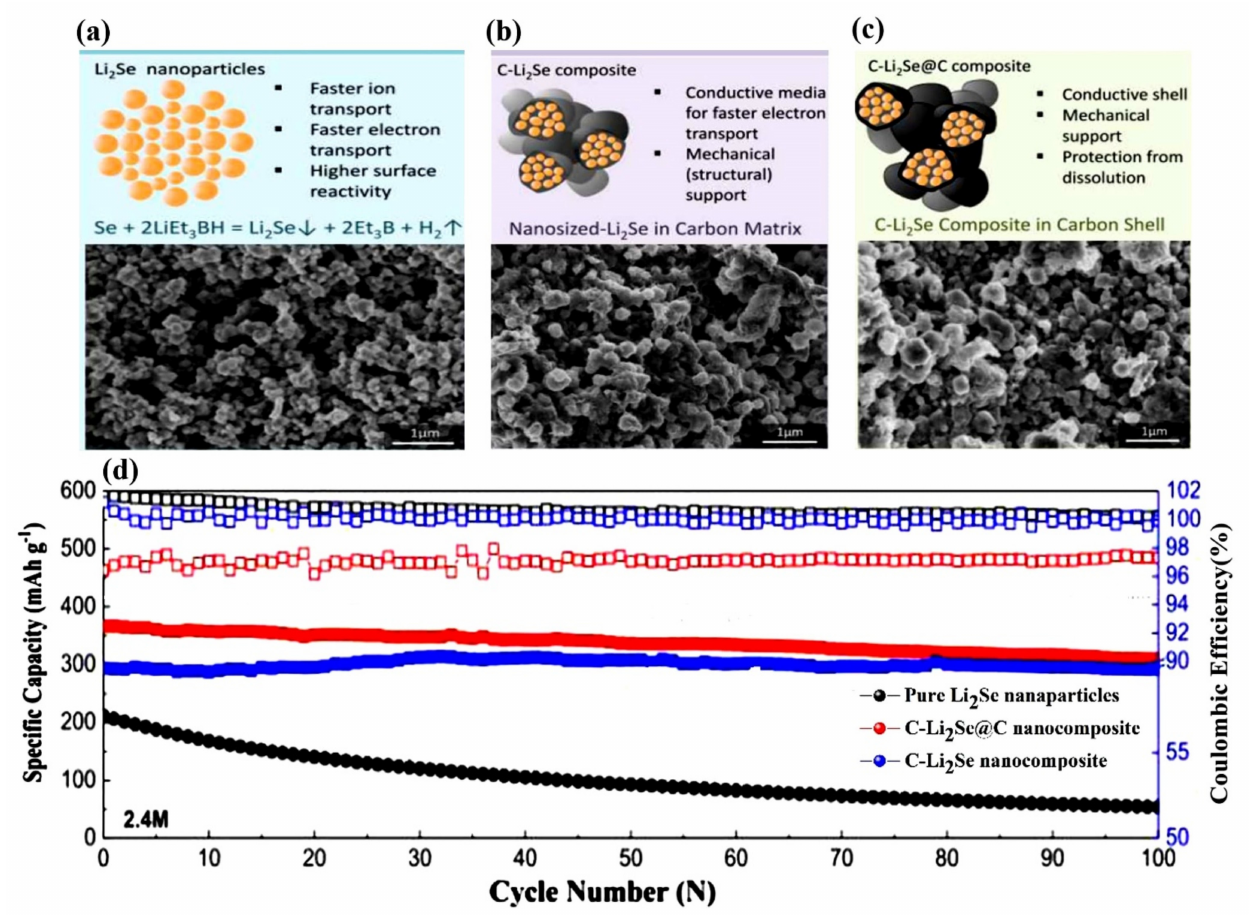
Figure 10. ( a ) Li 2 Se nanoparticles synthesized by a chemical reaction between Se powder and Li reducing agent (such as a lithium hydride solution), ( b ) C-Li 2 Se nanocomposite with Li 2 Se nanocrystals dispersed in an elastic matrix of conductive carbon and ( c ) C-Li 2 Se@C nanocomposite with C-Li 2 Se composite particles further enclosed in protective carbon shells. SEM micrographs of ( a ) pure Li 2 Se nanoparticles, ( b ) C-Li 2 Se nanocomposite, and ( c ) C-Li 2 Se@C nanocomposite illustrate experimental structures produced corresponding to each concept. ( d ) Retention of specific capacity and coulombic efficiency during 100 galvanostatic cycles at the C/2 rate. Reproduced with permission from [86], Copyright 2016, Elsevier BV. Table 3. Electrochemical performance of different Se-based composites for lithium-Se batteries. Sample Se